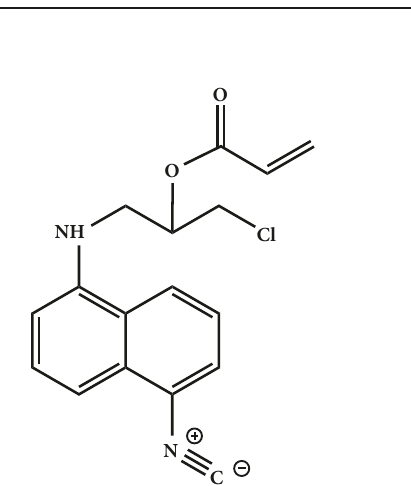
Figure 1: The molecular structure of 1-N-(2-acryloyloxy-3- chloroprop-1-yl)-amino-5-isocyanonaphthalene